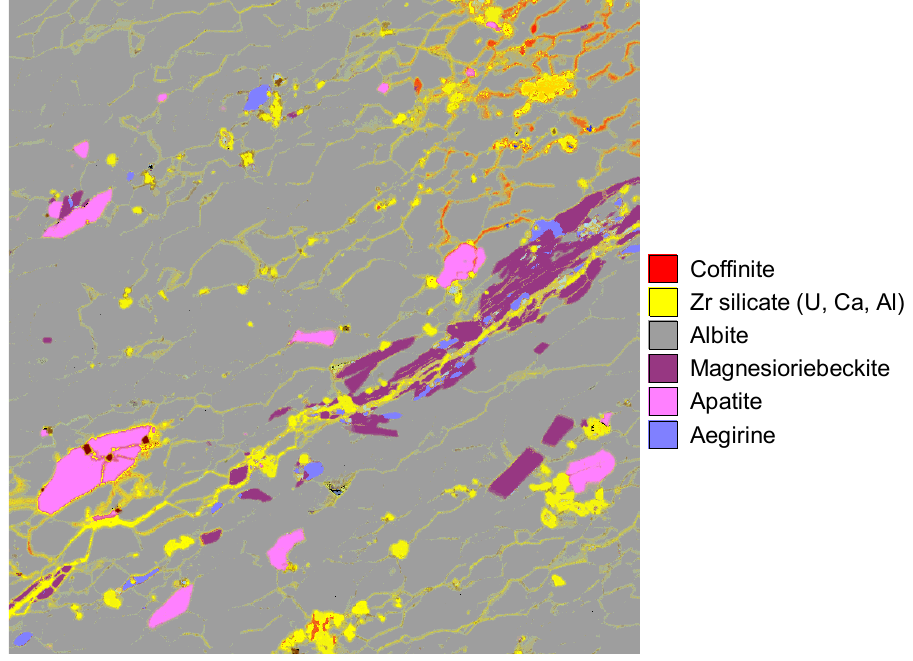
Figure 9. Phase patched map of sample from Valhalla drillhole VRD0205 163.1m region